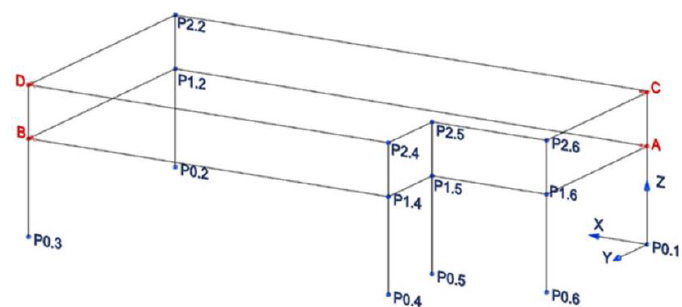
Figure 4. Identified monitoring points—Structure A.